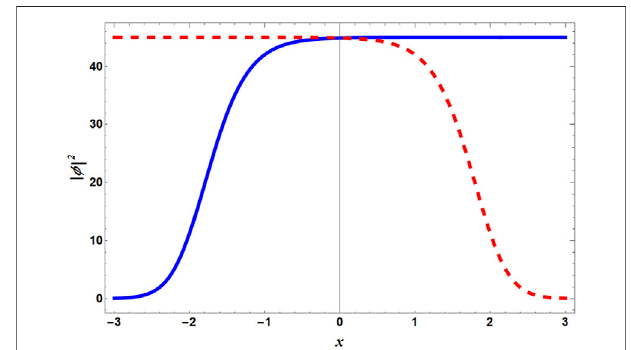
FIGURE 1 | (Color Online) Illustration of the kink – antikink solution following Eq.7 forarbitraryvalues of g and δ . Wehaveassumed g and δ g as5 and 0.5, respectively. Furthermore, v = 2, t = 1, and Z = m = 1. The blue solid line depicts the kink solution, that is, ϕ + , whereas the red dashed line represents the antikink, that is, ϕ − .